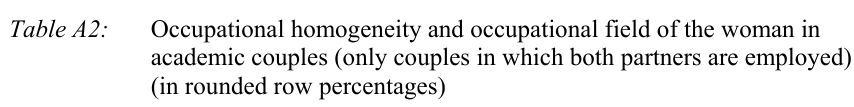
Table A2: Occupational homogeneity and occupational field of the woman in academic couples (only couples in which both partners are employed) (in rounded row percentages) % occupational Occupational Occupational Not specified field of female heterogeneous homogeneous partner (column percent- ages) sales/office jobs